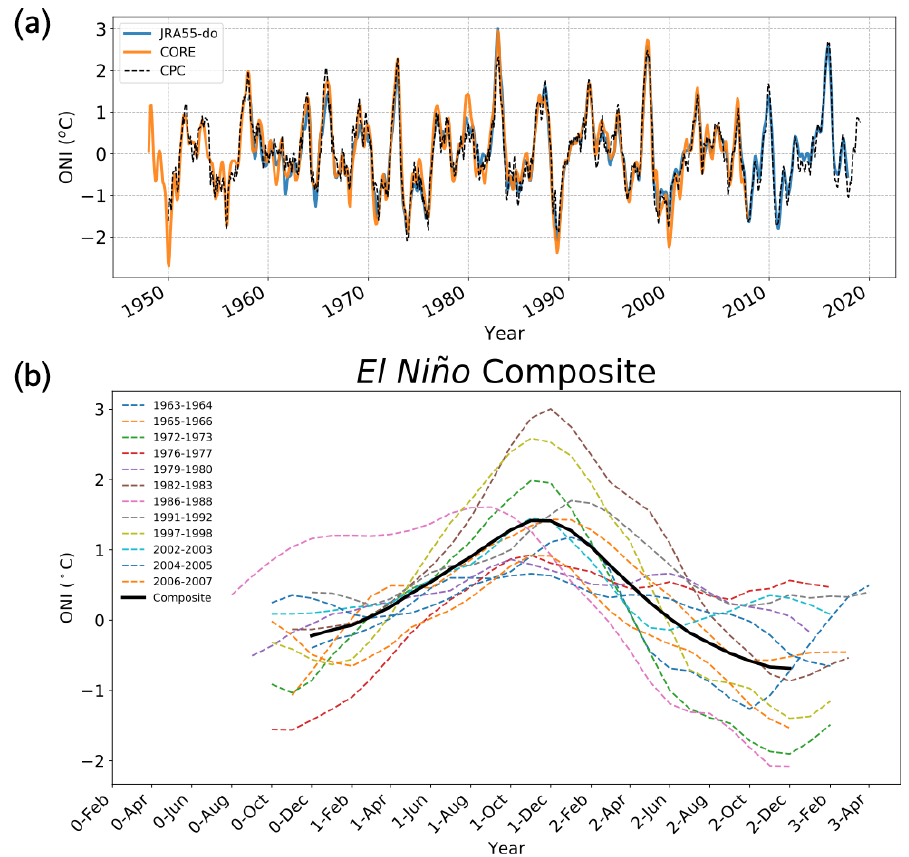
Figure 22. (a) The Ocean Niño Index (ONI) in JRA55-do (solid blue), CORE (solid orange), and observation provided by the Climate Prediction Center at the National Oceanic and Atmospheric Administration (dashed black). (b) All El Niño events picked out during the period of 1958–2007 to calculate the El Niño